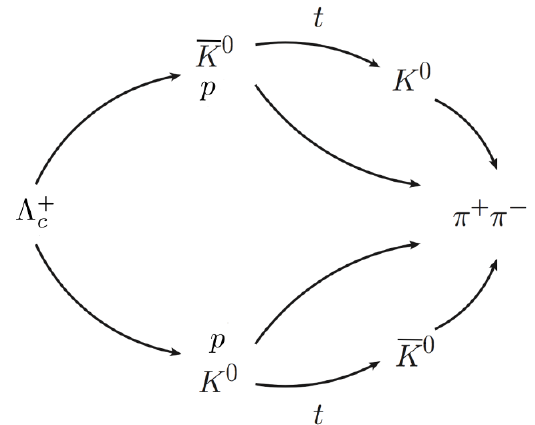
Figure 1 . Schematic description of the chain decay (cid:3) +